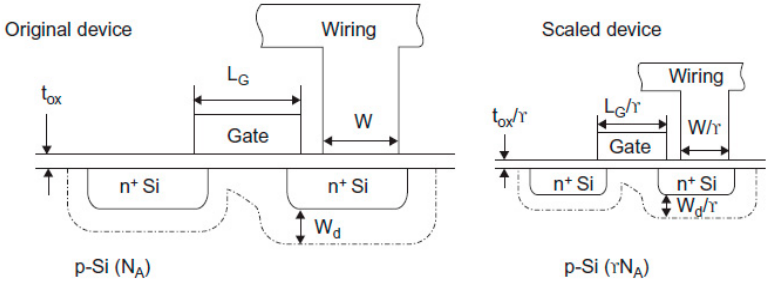
Figure 2. A schematic drawing of MOSFET downscaling [23].